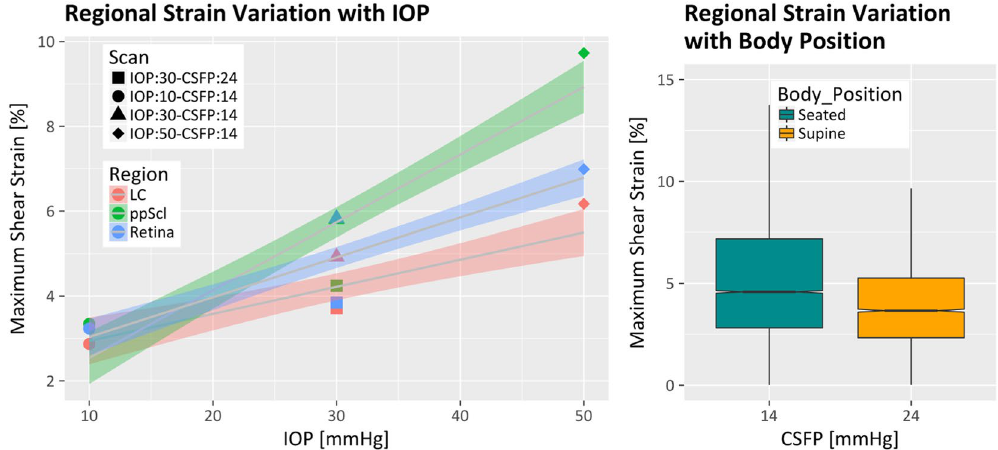
Figure 4. ( l ) Regression line and confidence intervals of the change in Maximum Shear Strain with IOP for the lamina cribrosa (LC), peripapillary (ppScl), and peripapillary retina regions. Each marker represents the average strain difference between each follow-up scan against the reference scan (IOP:10; CSFP:24). Strain was consistently lower for each ONH region in the scan at supine position. (r ) Strain change associated with a variation in CSFP at constant IOP (30 mmHg). To a CSFP increase the average strain decrease of − 0.14%/ mmHg (p < 0.0264), which was comparable in magnitude to the strain increase associated with an increase in IOP.